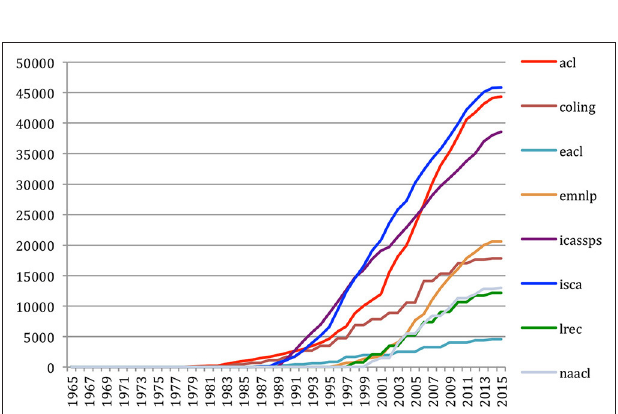
FIGURE 40 | Number of papers that have been cited over the years for the eight most important conferences.